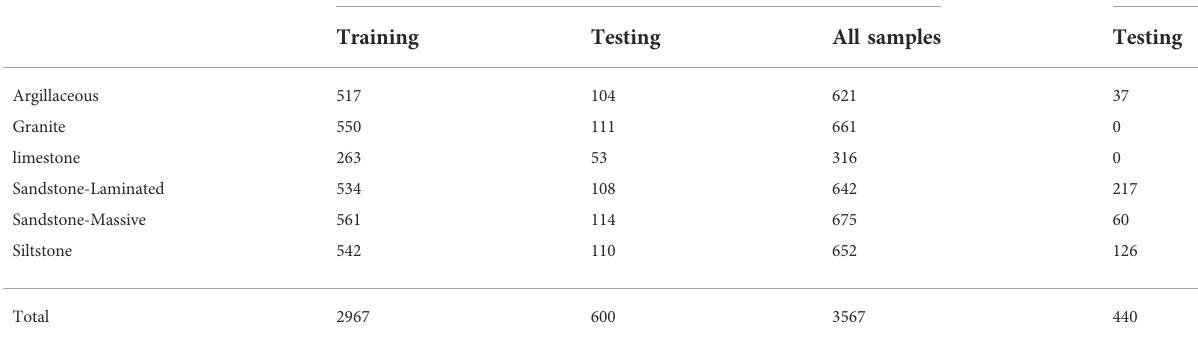
TABLE 1 Datasets